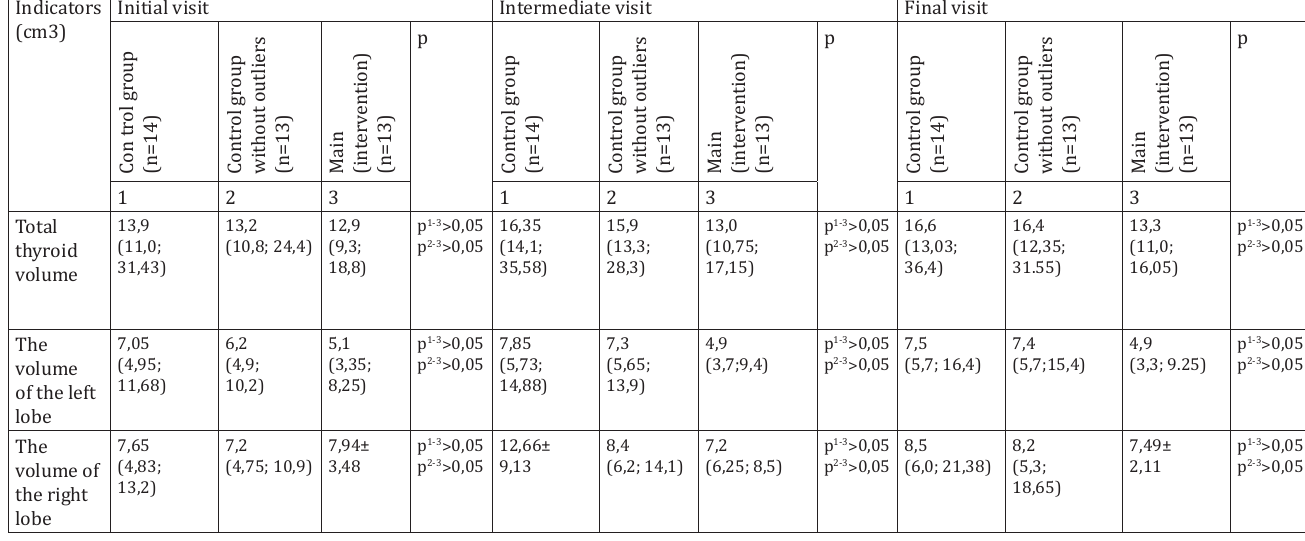
Average volume of nodes (cm3) during the study period